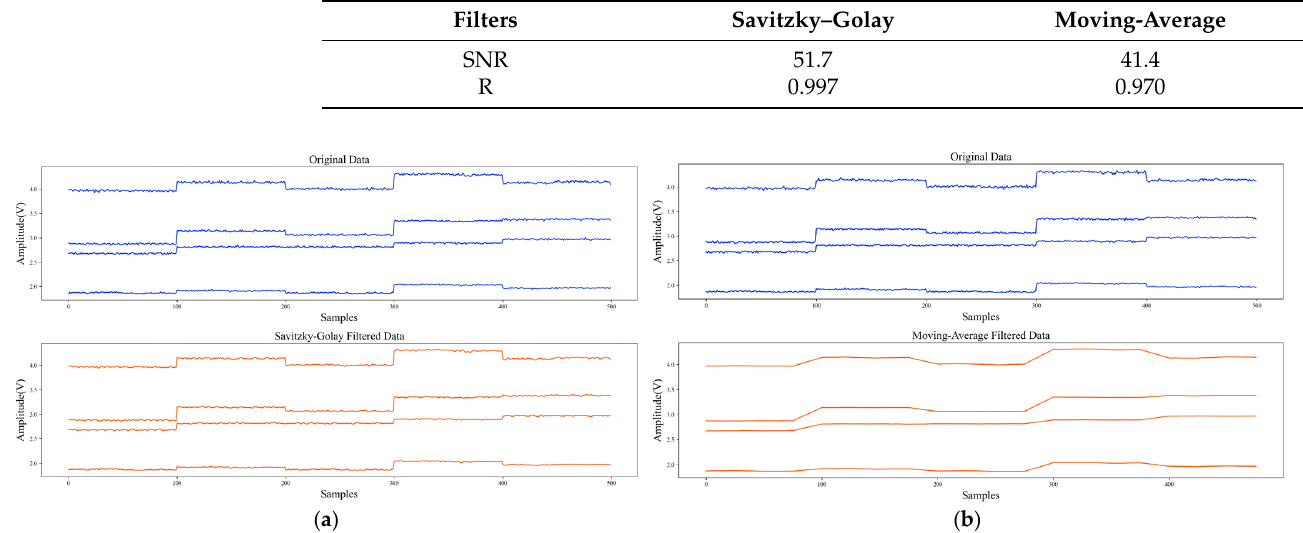
Table 3. Comparison of different filters.